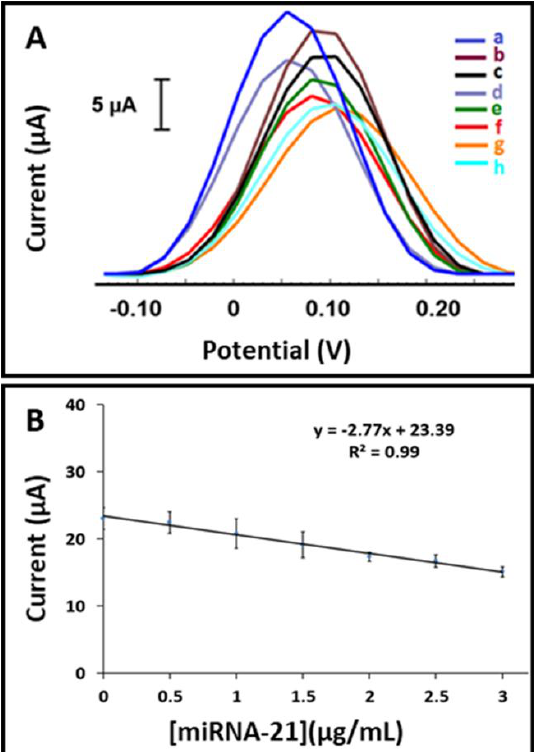
Figure 7. ( A ) Voltammograms representing the [Fe(CN) 6 ] 3−/4− oxidation signals obtained by (a) Probe-2 immobilized AuNP/MoS 2 -paper electrode in the absence of miRNA-21 target, after hybridization of Probe-2 with miRNA-21 target at concentrations of (b) 0.5 µg/mL, (c) 1.0 µg/mL, (d) 1.5 µg/mL, (e) 2.0 µg/mL, (f) 2.5 µg/mL, (g) 3.0 µg/mL, and (h) 5.0 µg/mL. ( B ) The calibration plot for AuNP/MoS 2 -paper electrode obtained after hybridization between Probe-2 and miRNA-21 target with its various concentrations from 0 to 3.0 µg/mL ( n = 3).